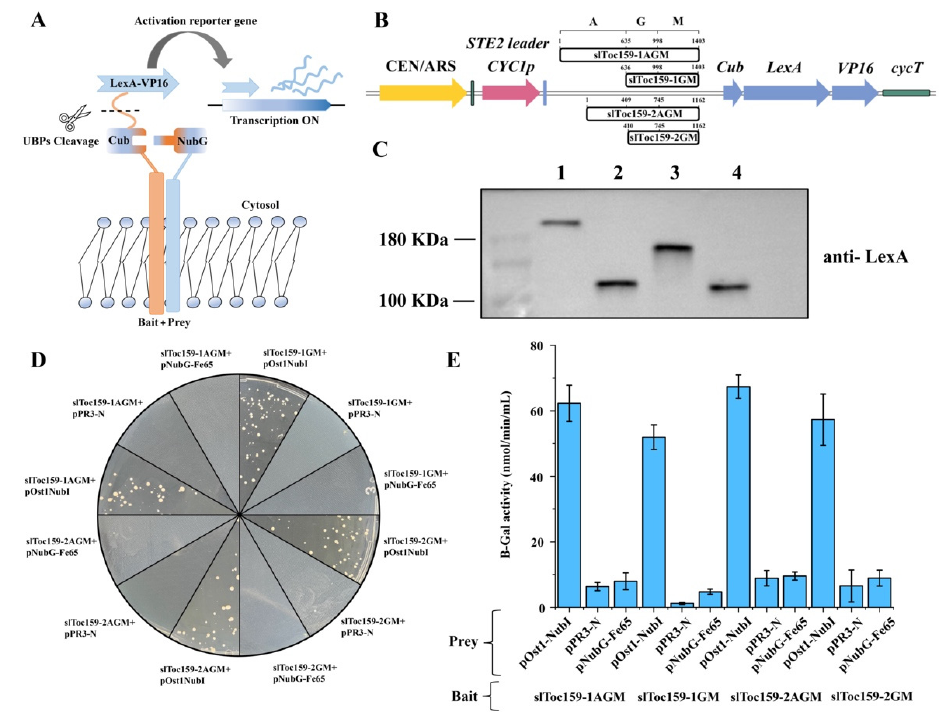
Figure 1. Analysis of slToc159-1AGM, slToc159-1GM, slToc159-2AGM, and slToc159-2GM bait plas- mids transformed into NMY51. ( A ) Split-ubiquitin yeast two-hybrid mechanism. ( B ) Diagrammatic representation of the domain organization of the slToc159-1AGM, slToc159-1GM, slToc159-2AGM, and slToc159-2GM bait constructs in the yeast plasmid, pBT3-STE. The bait vector provides an upstream yeast STE2 leader sequence and yeast ubiquitin Cub (34–76 aa), LexA, and VP16 genes downstream. Fusion proteins produced by this cassette are expressed constitutively by the yeast CYC1 promoter and terminator. The bait protein domains were cloned directionally (using SfiI) into the position indicated. The numbers refer to the amino acid sequence of atToc159 or atToc132. ( C ) Immunoblot analysis of whole cell extracts of NMY51 yeast strains expressing the bait proteins. 1: slToc159-1AGM; 2: slToc159-1GM; 3: slToc159-2AGM; 4: slToc159-2GM. ( D ) The split-ubiquitin membrane-based yeast two-hybrid analysis confirming the expression of the bait proteins. The slToc159-1AGM, slToc159-1GM, slToc159-2AGM, or slToc159-2GM bait protein was co-expressed